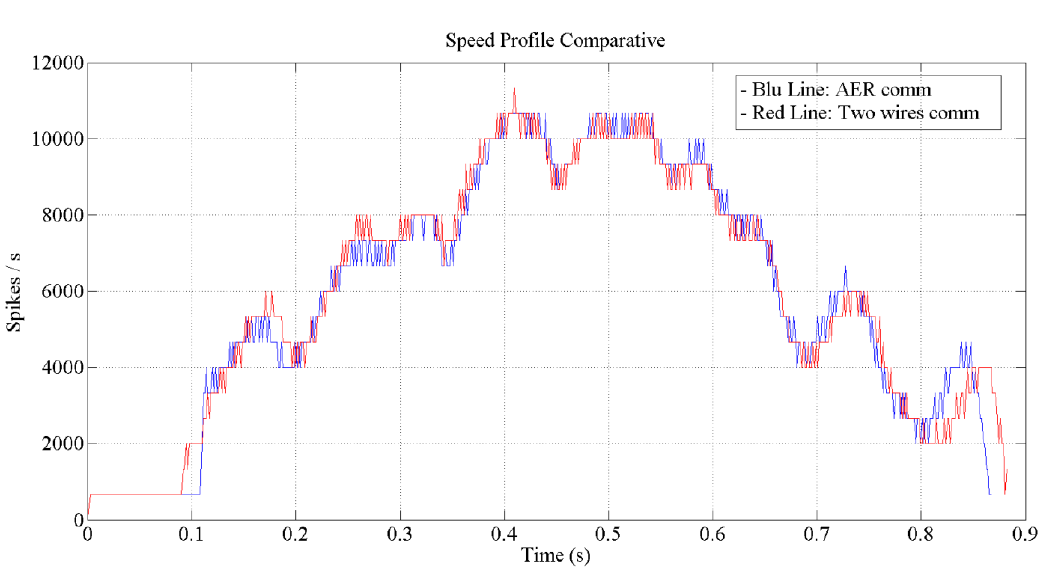
Figure 15. Speed profiles read out from motor encoders. The blue profile is read with an AER communication and the red profile is from a pair of wires communication. The input was an AER address matching coordinate 125 for the x-axis.